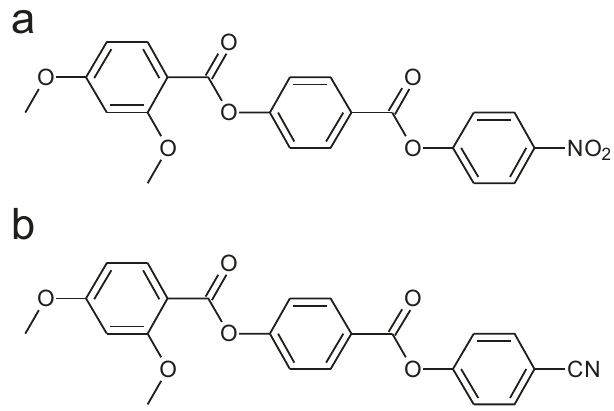
Fig. 1 Chemical structure of mesogens used in this study. Molecular structures and transition temperatures (°C) of a RM734 — Cr 139.8 (N S 132.7) N 187.9 Iso, and b RM734-CN — Cr 173.2 N 200.4